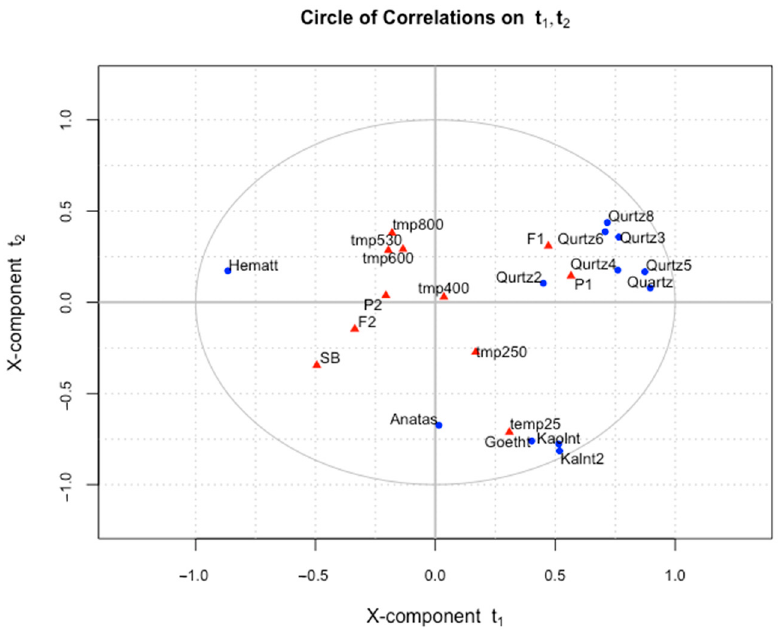
Figure 4. Correlation plot between components t 1 and t 2 . Red points: heating temperature and collection sites. Blue points: minerals. Hematt—hematite. Qurtz—quartz (more than one peak was considered). Anatas—anatase. Goetht—gothite. Kaolnt—kaolinite (more than one peak was considered). Tmp—temperature.